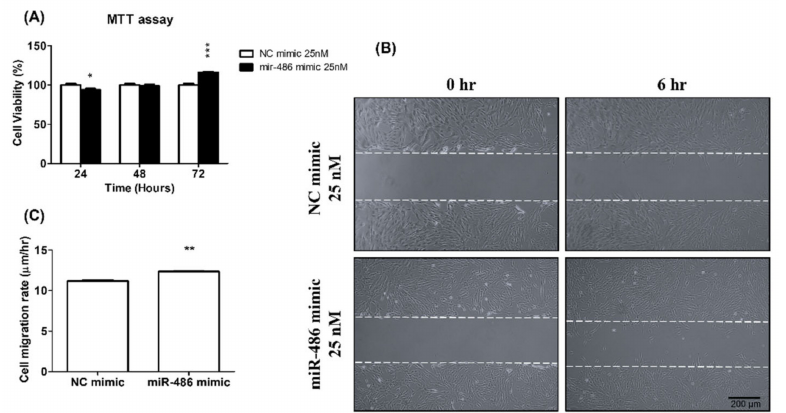
Figure 2. miR-486-5p induced HPAMC proliferation and migration. ( A ) HPASMCs were transfected with the miR-486-5p mimic or NC mimic, and cell viability at 24, 48, and 72 h was determined with an MTT assay ( B , C ). The migration ability of HPASMCs was determined with a wound-healing assay. After creating wound gaps, cells were incubated for 6 h, and the cell migration rate was determined by calculating the distance migrated by the cells into the wound area. Scale bar: 200 µ m. Results are expressed as the means ± SEMs ( n ≥ 3). * p < 0.05, ** p < 0.01 and *** p < 0.001 compared with the NC mimic group.